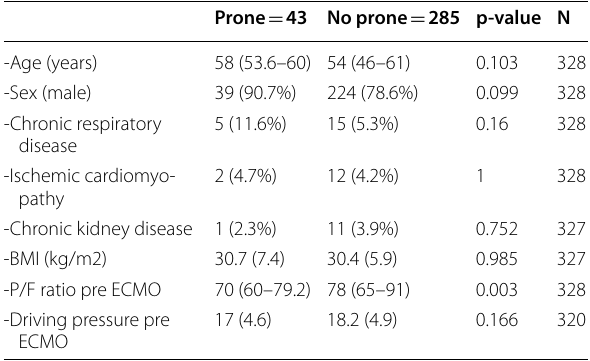
Table 1 Characteristics and